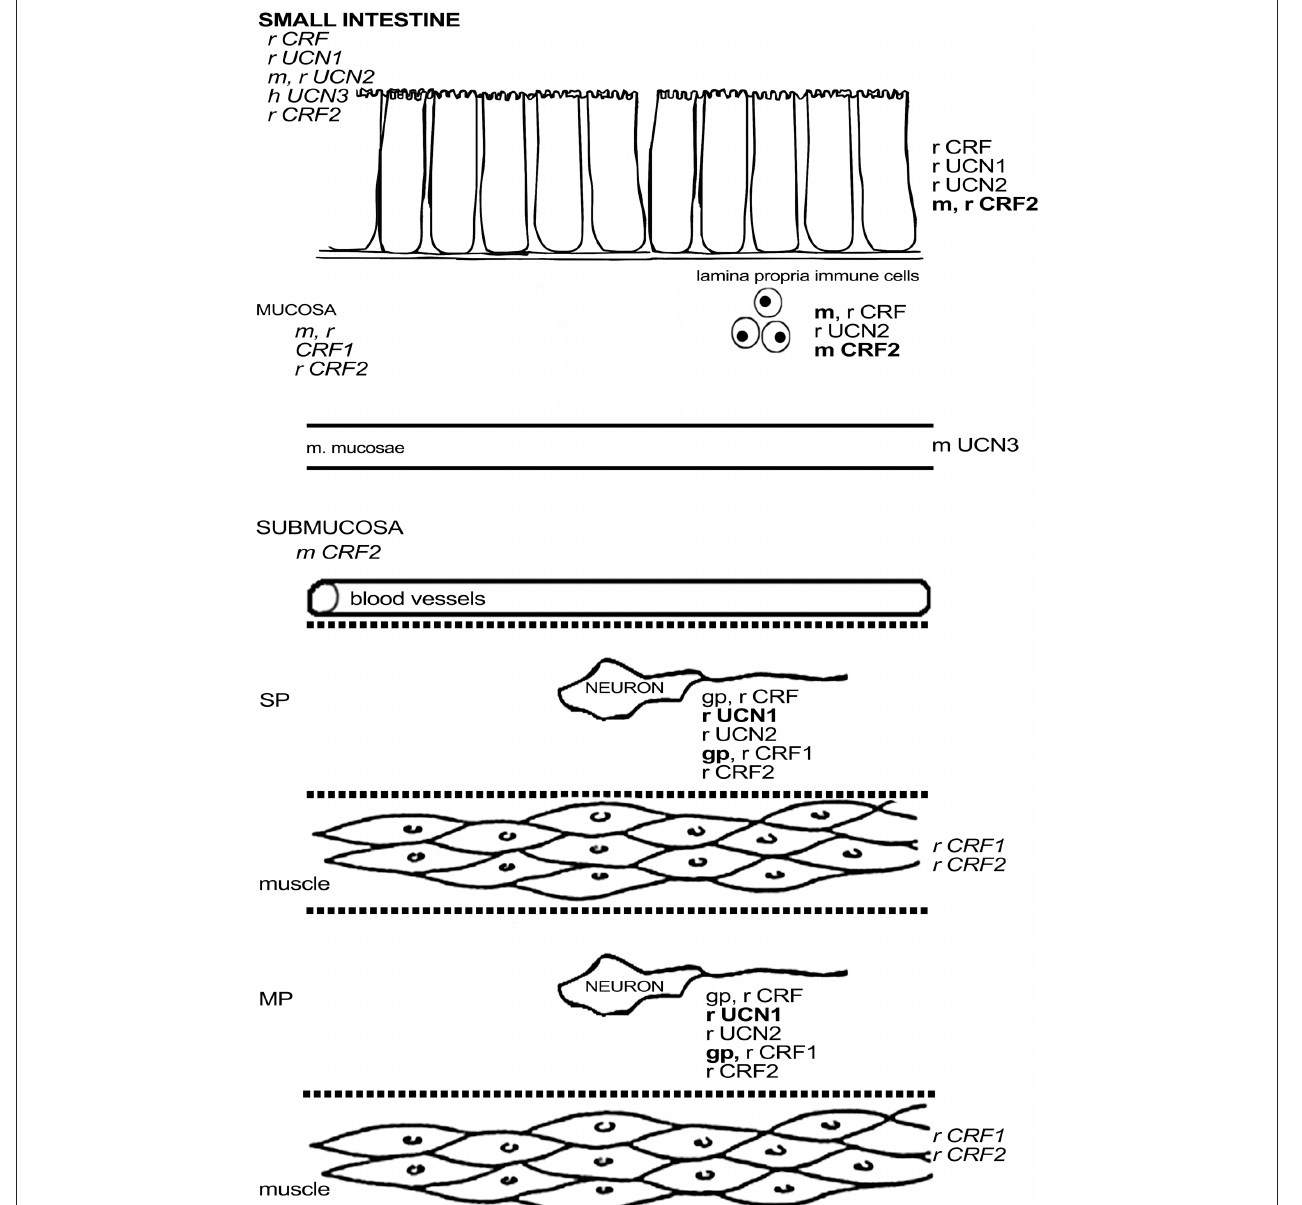
Figure 2 | Schematic overview of the expression of CrF-related proteins in the small intestine. Regular font indicates that protein expression has been described, italic font indicates that mRNA expression has been described, bold